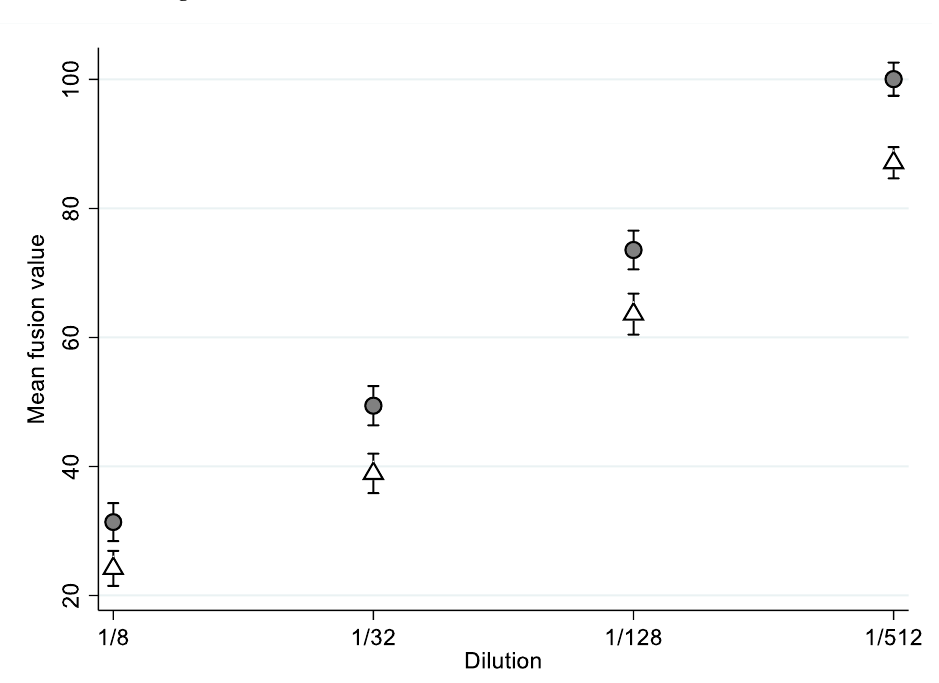
elderly people in grey. Figure 1. Mean fusion value by groups and by dilution. Young people are represented in white and